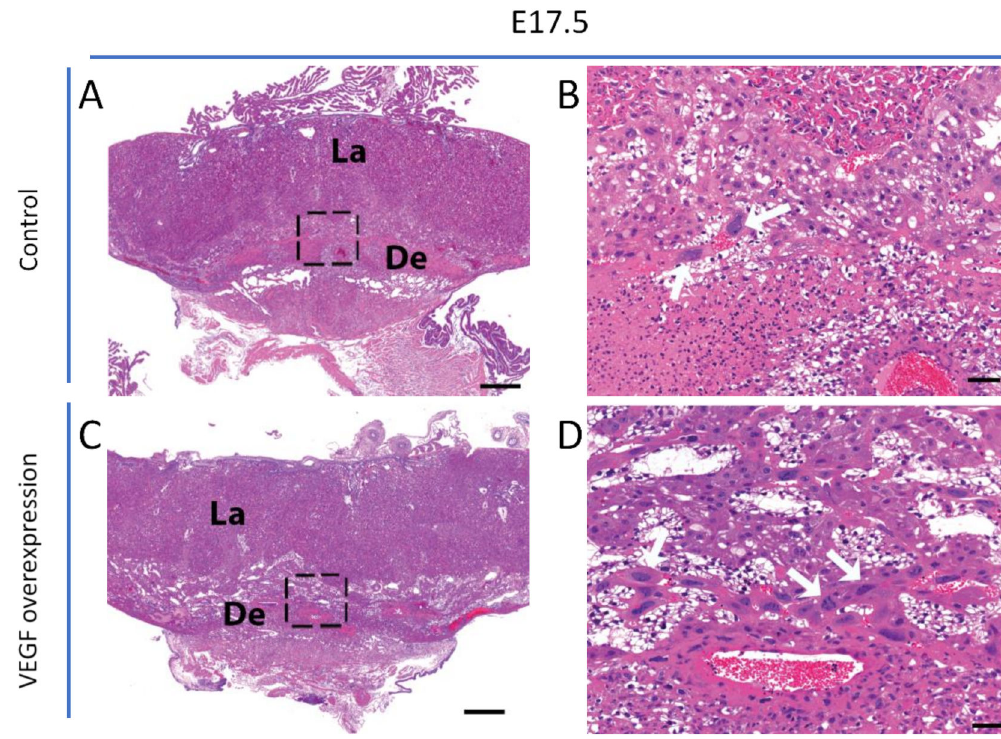
Figure 2. Pregnancies at term exhibit less impact on TGCs. Full-thickness H&E-stained placentas at E17.5 ( A–D ). Control dams exhibiting normal placental development at E17.5 ( A , B ). Placentas surviving to term in endometrial VEGF- overexpressing dams at E17.5 showing changes in TGCs (indicated by white arrows within the insets, C , D ) but no discernible effect on maternal blood spaces in the placenta ( C , D ) compared to the controls ( A , B ). De, decidua; La, labyrinth; TGC, trophoblast giant cells. Scale bar in A and C = 500 µm. Scale bar in B and D = 50 µm.